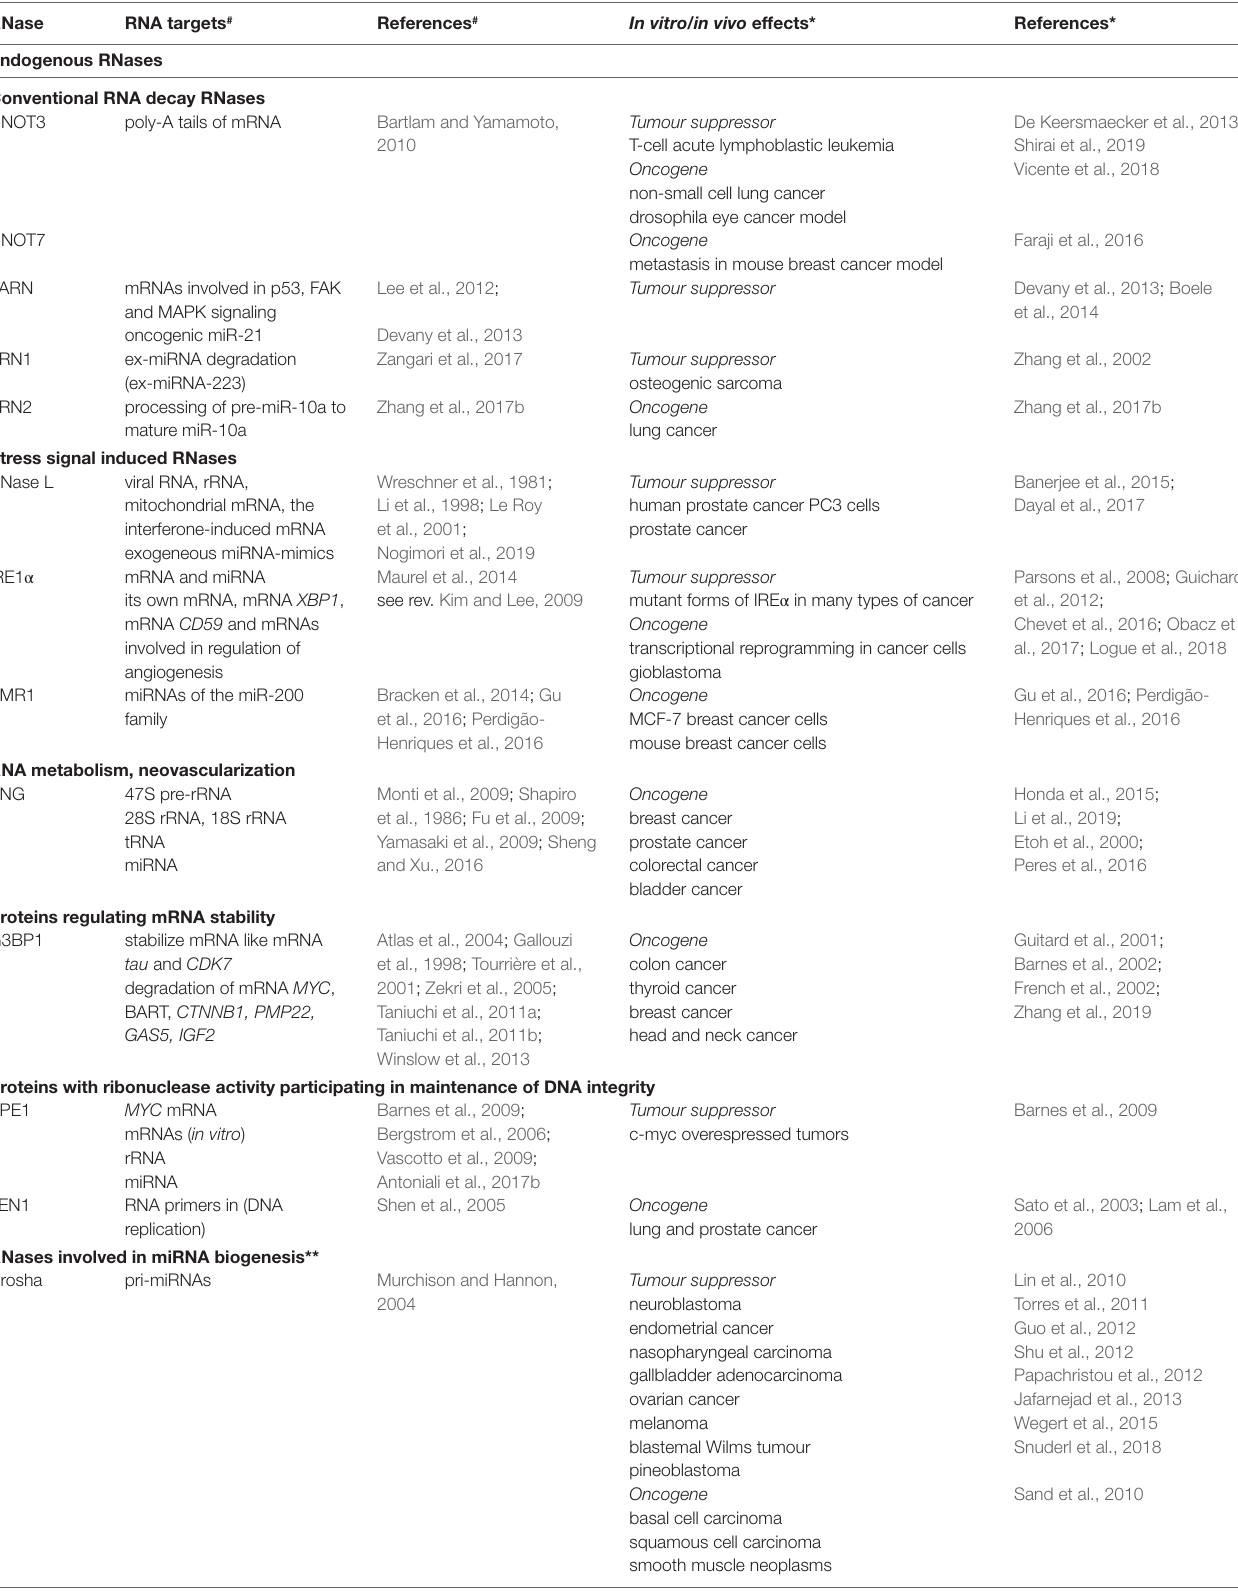
TABLE 3 | Endogenous RNases and their role in cancer